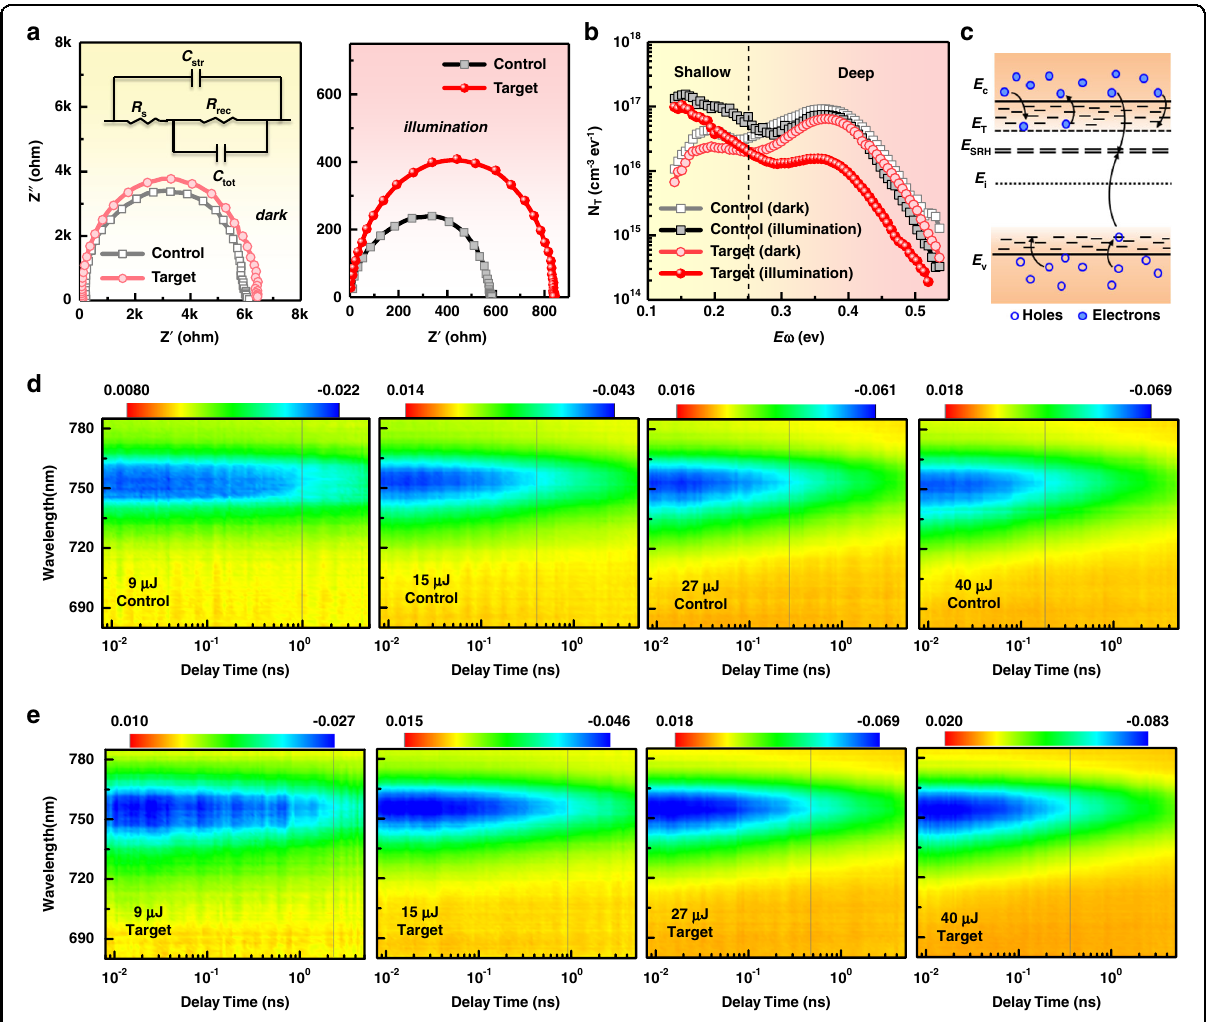
Fig. 4 Characterization of carrier dynamics under dark and illuminated conditions. a Nyquist plots of EIS characterization under dark and illumination at a bias of 0.8 V for MAPbI 3 -based control and target devices. The inset shows the equivalent electrical circuit model, consisting of a single parallel connection of R rec and a chemical capacitance ( C rec ) connected to a series resistance R s . b t DOS for control and target MAPbI 3 perovskite devices in TAS analysis. c Energy-band diagram of the perovskite fi lm representing the carrier recombination and trapping/detrapping processes. d , e Pseudo-colour representation of time-resolved transient absorption spectra for the control and target MAPbI 3 fi lms, following 532 nm pulsed laser excitation with various pump fl